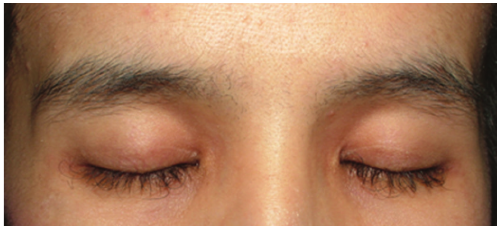
Figure 3: Trichomegaly. Trichomegaly developed in a 40-year-old woman, 3 months preceding erlotinib. Notice the wavy, curly, and aberrant elongation of the eyelashes.